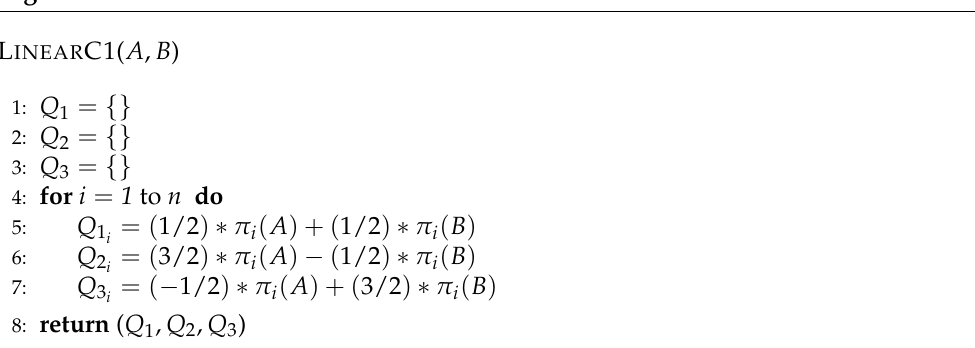
Algorithm 8 Linear Crossover-L INEAR